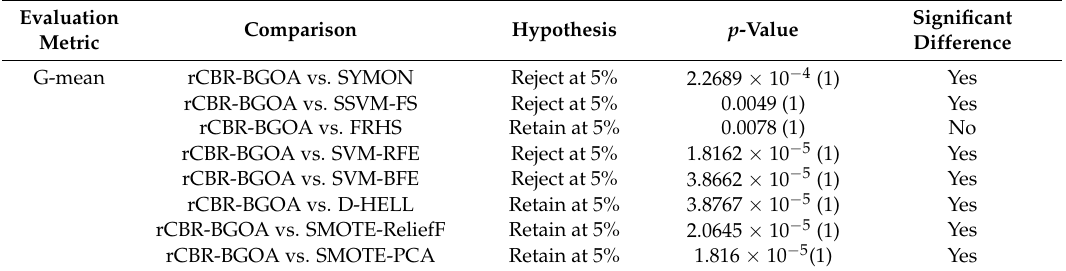
Table 6. Wilcoxon signed-rank test for G-mean evaluation